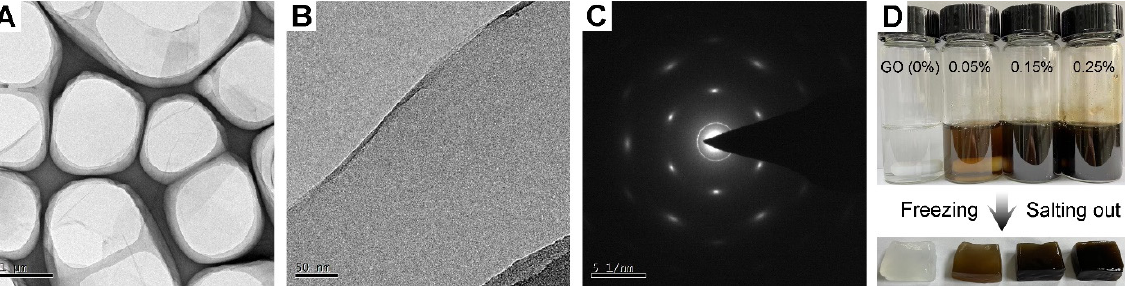
Figure 2. Morphology characterization of prepared GO. ( A ) Transmission electron microscope image of GO. ( B ) High-resolution transmission electron microscope images of GO. ( C ) The corresponding selected electron diffraction pattern. ( D ) Digital photos of PVA/GO ionic conductive hydrogels with different GO contents prepared under the synergistic effect of freezing and salting out.